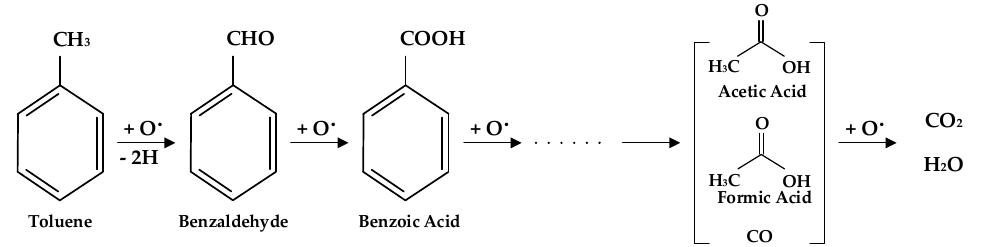
Figure 2. Proposed initial schematic route of the reaction of adsorbed toluene molecules with imme- diately adjacent adsorbed active oxygen species, forming toluene oxidation by-products. Reprinted with permission from references [51,53,54]. Copyright 2021 Elsevier.